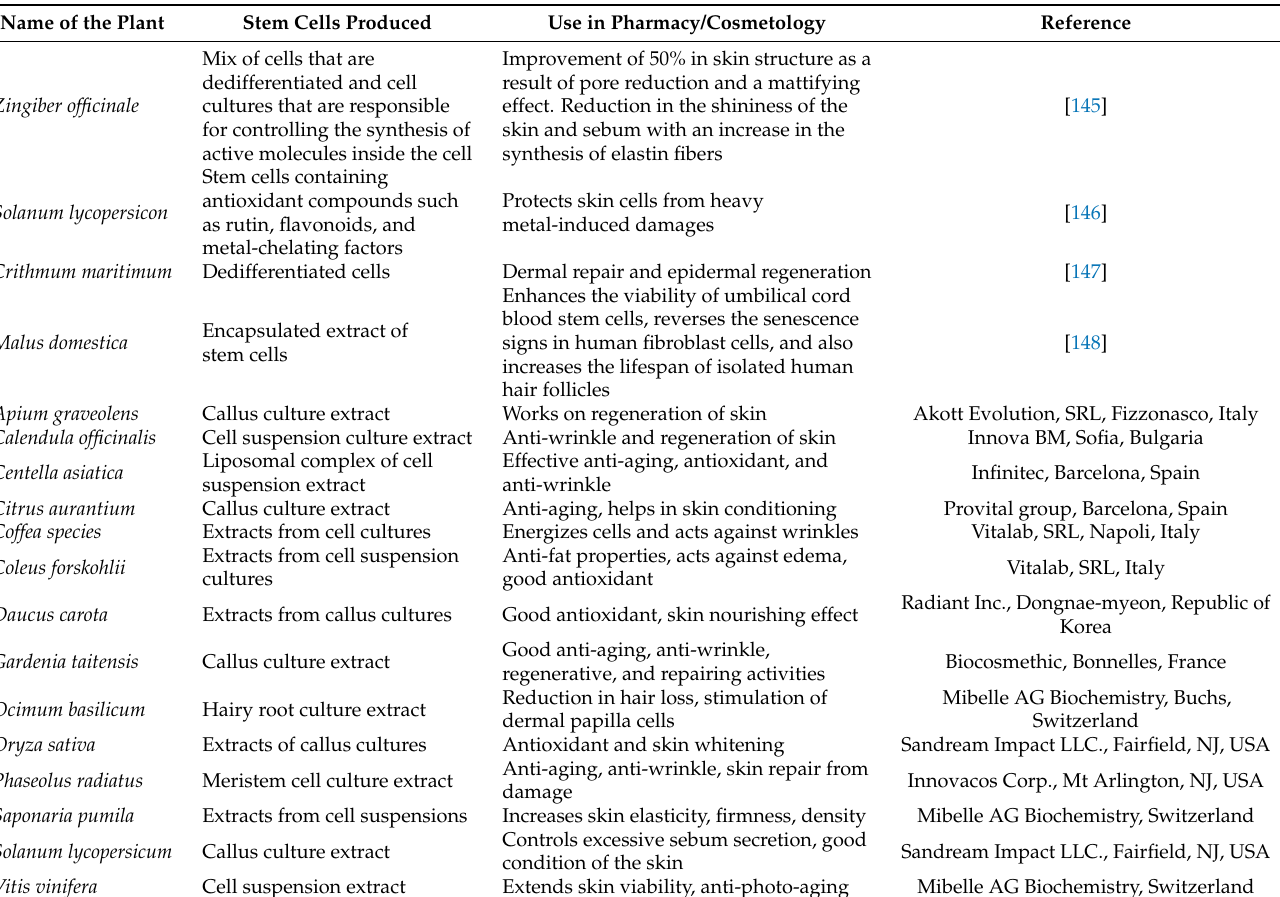
Table 2. Plant stem cells/callus/suspensions/hairy roots being used for cosmetic purposes by different